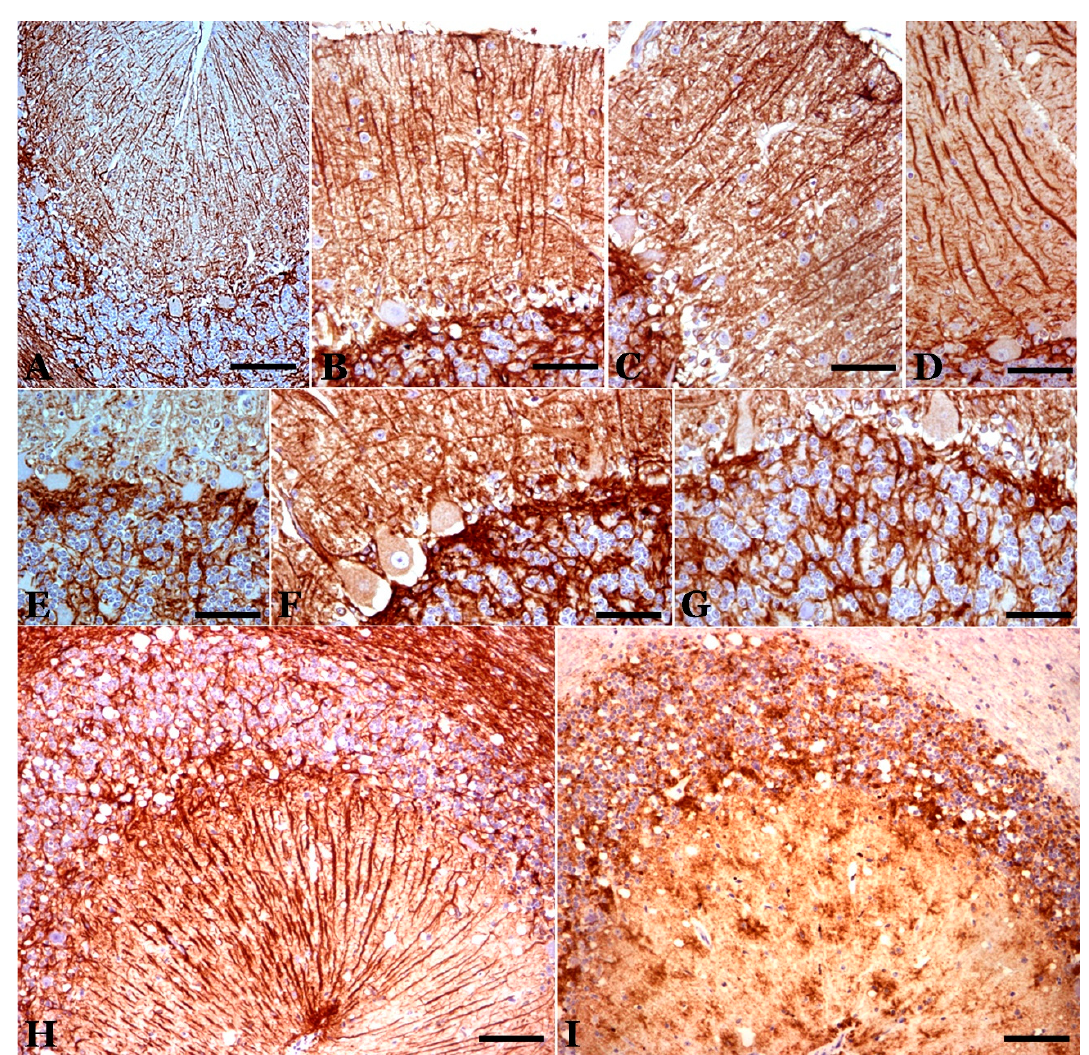
Figure 5. Astrogliosis in the cerebellar cortex of preclinical ( A ), clinical ( B – F ) and terminal ( G ) scrapie cases (GFAP immunostaining plus hematoxylin contrast). In the preclinical stage, the astroglial pattern is similar to that observed in controls. In the clinical stage, greater astrogliosis is observed, which can present different characteristics in different folia. In ( B ) and ( C ), there is hyperreactivity and hypertrophy in the astrocytes of the granular layer and in the Bergmann fibers of the molecular layer. In ( D ), great hypertrophy of these fibers is shown. ( E ) and ( F ) show greater astrogliosis in the basal area of the Purkinje layer. ( G ) Astrogliosis in a case of terminal scrapie. ( H , I ). Parallel GFAP ‐ immunostained ( H ) and abnormal PrP ‐ immunostained ( I ) sections, respectively. There is a coincidence of granular deposits of abnormal PrP deposits/deposition in the Purkinje layer and the granule cell layer, but the star ‐ shaped deposits in the molecular layer do not correspond to GFAP ‐ immunopositive stellate astrocytes in the molecular layer. (Bar: A = 50 μ m; B–E = 40 μ m; F,G = 25 μ m; H,I = 50 μ m).